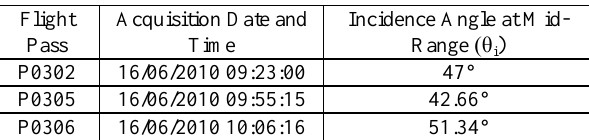
Table 1. Acquisition